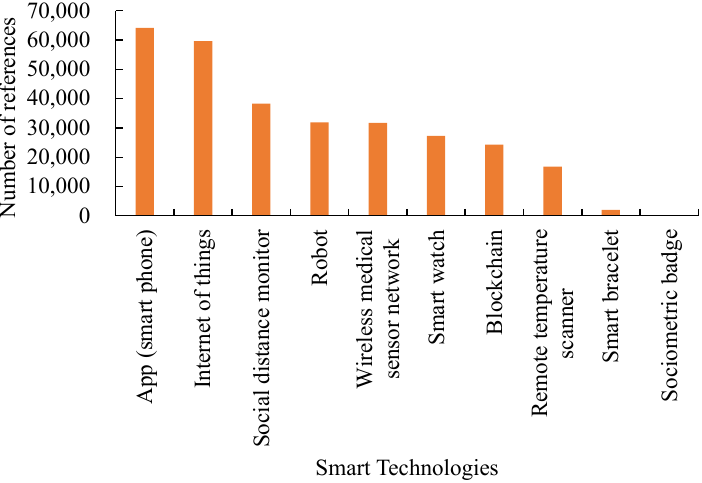
Figure 1. Number of references related to a specific smart technology application to mobile healthcare since 2020 [43].